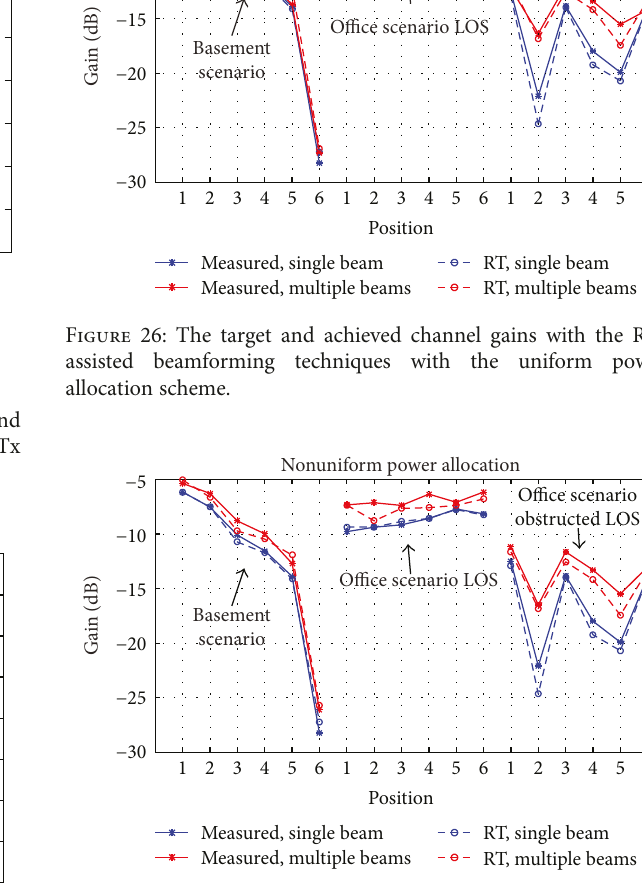
Figure 27: The target and achieved channel gains with the RT- assisted beamforming techniques with the nonuniform power allocation scheme.